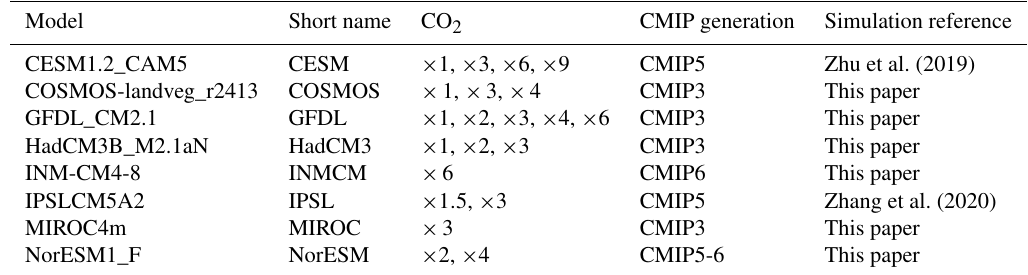
Table 1. Summary of the DeepMIP Eocene model simulations described and presented in this paper. In addition to the simulations listed, each model has an associated preindustrial control. More information about the spin-up of each simulation is given in Table S2. In this paper, each model is referred to by its short